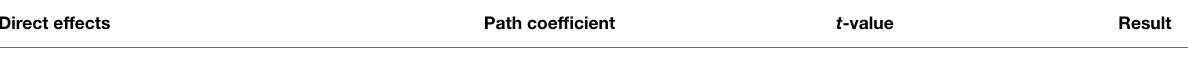
TABLE 3 | The path analysis results. Paths Direct effects